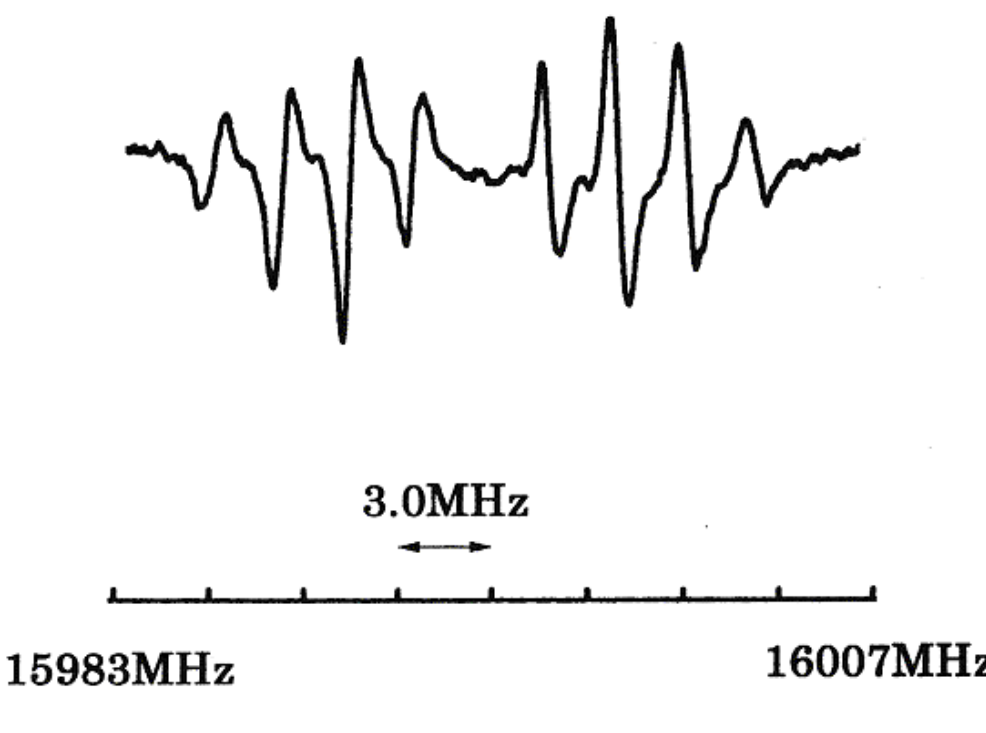
Figure 5. Stark pattern of the P(5,4) line in the (2,A, 4) sequence observed with the upper sideband of 9P(40) CO 2 laser line. The horizontal axis is the modulation